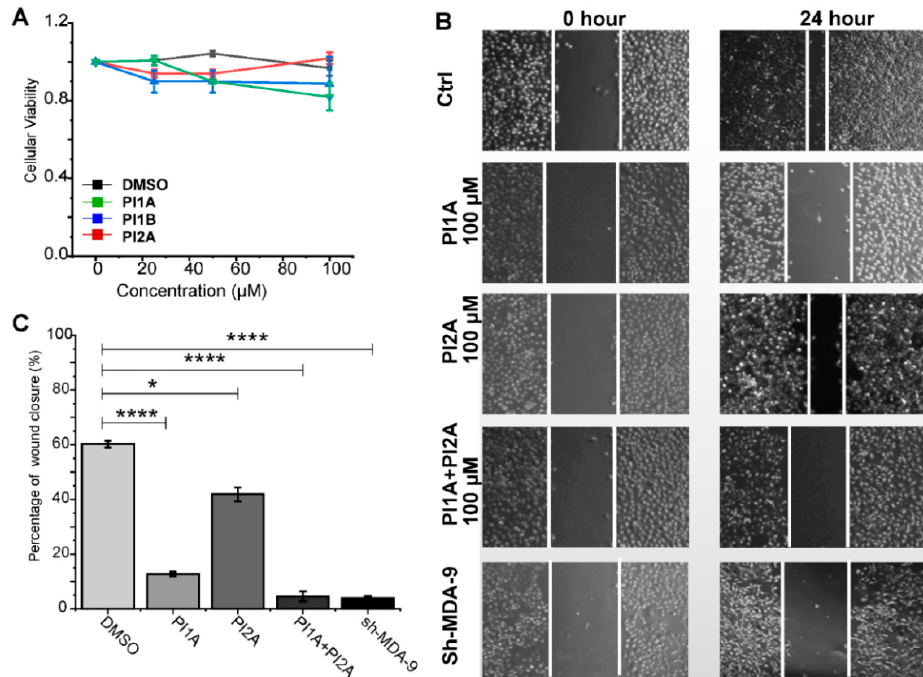
Figure 5. PI1A and PI2A inhibit the migration of MDA-MB-231 cells. ( A ) Viability of MDA-MB-231 cells assayed by CCK8 after treatment of PI1A, PI1B, and PI2A for 48 h. ( B ) Wide-angle micrographs of MDA-MB-231 cells treated by DMSO, PI1A (100 μ M), or PI2A (100 μ M) for wound healing assays. Cell migration recorded at 0 and 24 h. ( C ) Statistics of the wound closure relative to control (DMSO- treated cells). The mean ± standard deviations were estimated from three biological duplicates. The p values were retrieved from the one-way analysis of variance (ANOVA) with a Bonferroni post-test (* p < 0.05, **** p < 0.0001). Table 1. Primers used on this report.